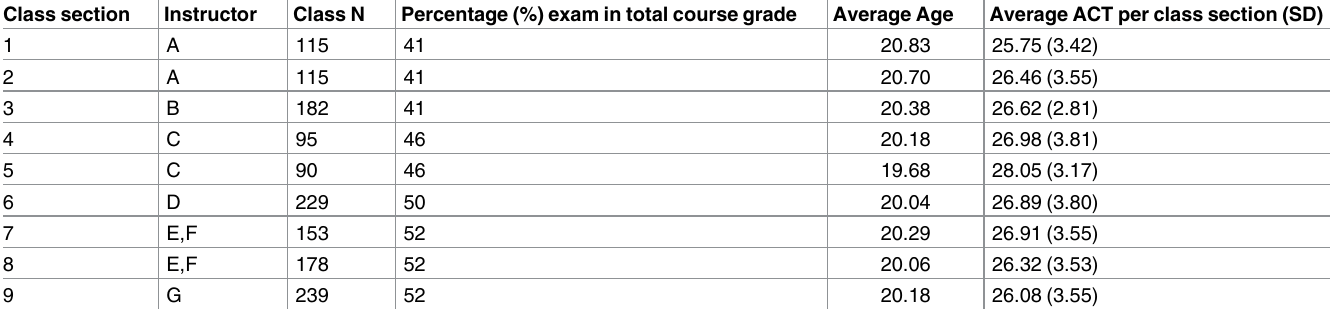
Table 1. Characteristics of nine introductory-biology courses analyzed for